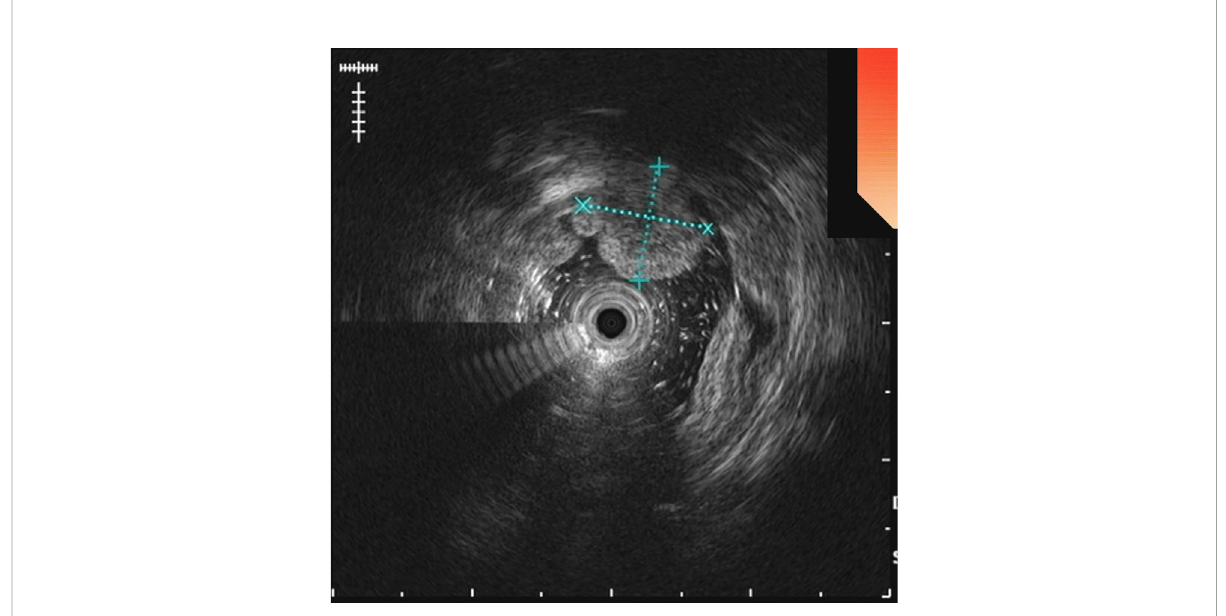
FIGURE 6 EUS examination demonstrates duodenal lymphangioma with